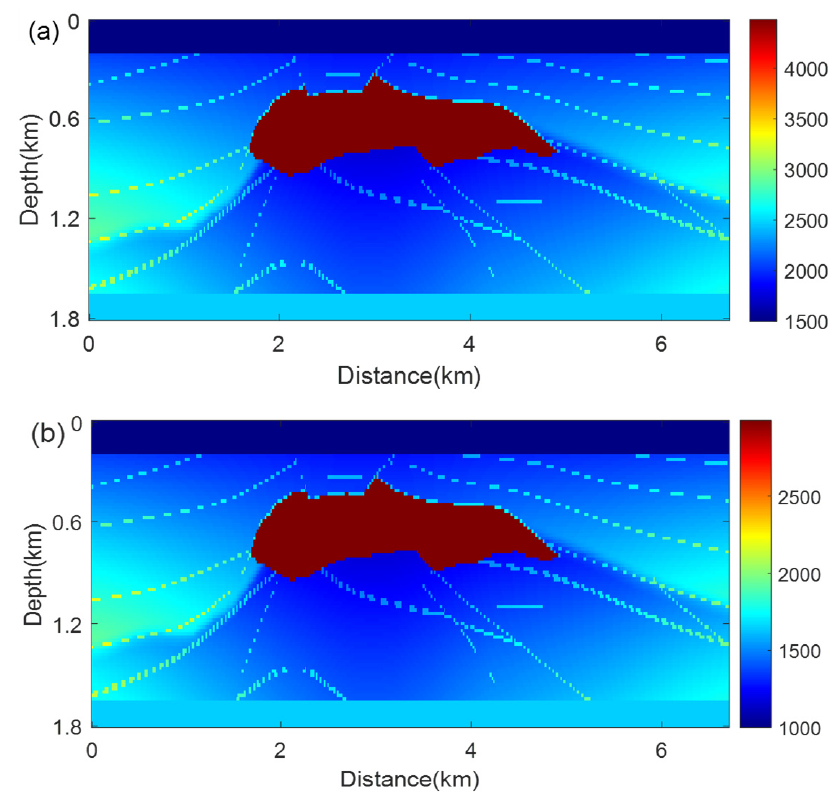
Figure 2. The modified SEG/EAGE salt dome model for elastic media. ( a ) True Vp model; ( b ) True Vs model.